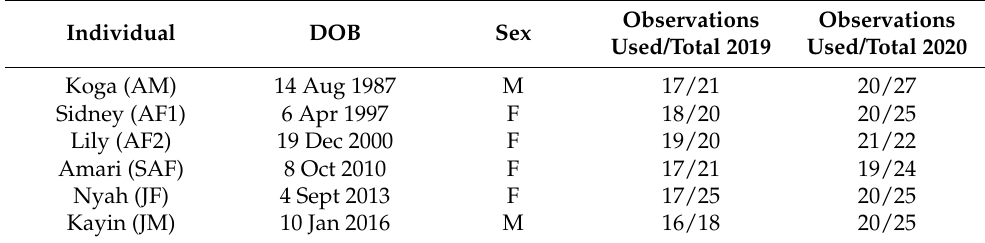
Table 1. Subjects for study and number of observations per subject during the 2019 and 2020 sampling periods. AM = adult male, AF = adult female, SAF = subadult female, JF = juvenile female, JM = juvenile male. Observations in which the focal subject was out of view for more than half the scans was not included in analyses. The table reflects the number of observations used out of the total number of observation sessions